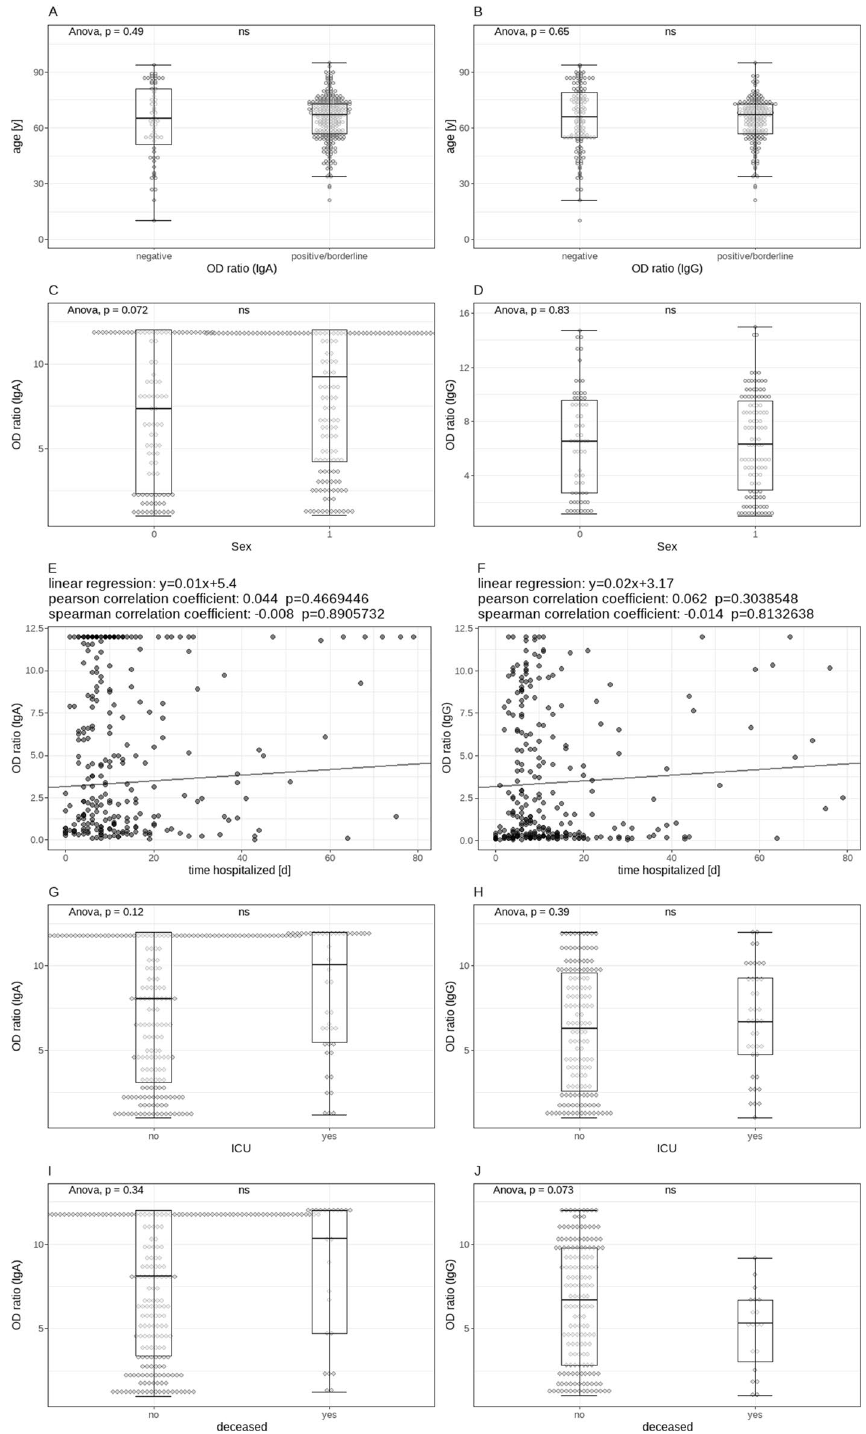
Figure 7. Visualization of the relationship between the detection of anti-SARS-CoV-2 antibodies and age ( A , B ), sex ( C , D ), duration of hospitalization ( E , F ), treatment in the ICU ( G , H ) and death ( I , J ) for all samples of our cohort. No statistically significant associations could be found for any of these